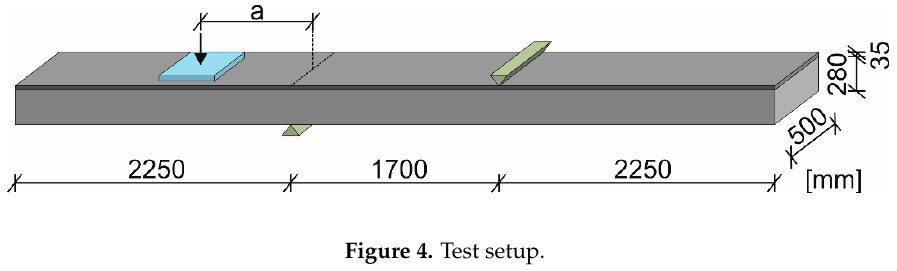
Table 1. Amount of CTRM and steel, effective depth d s of the RC slab and the load distance a .